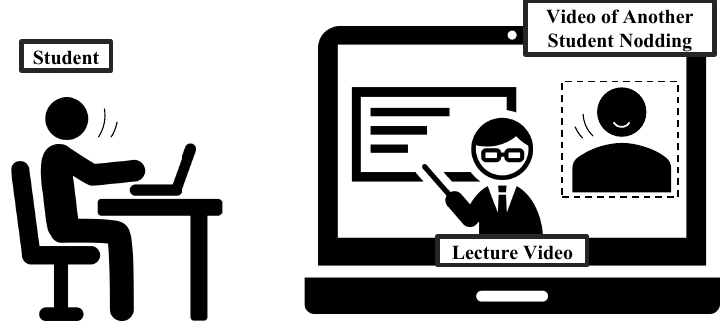
Figure 1. Image of the method to encourage natural